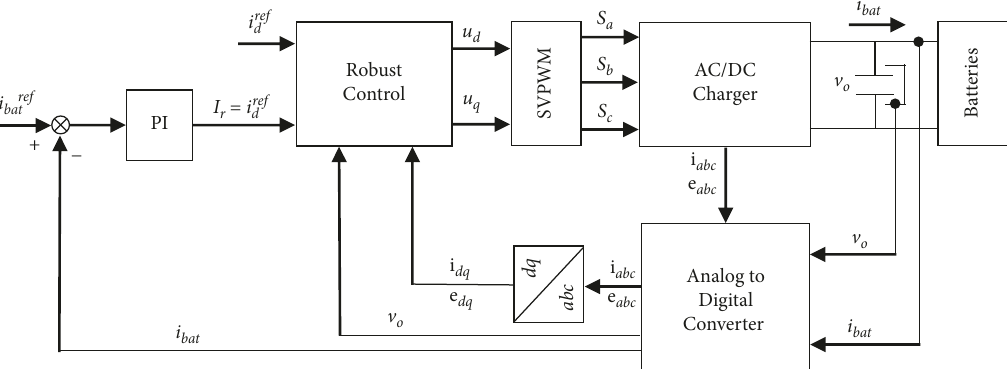
Figure 3: Block diagram of CC mode control.